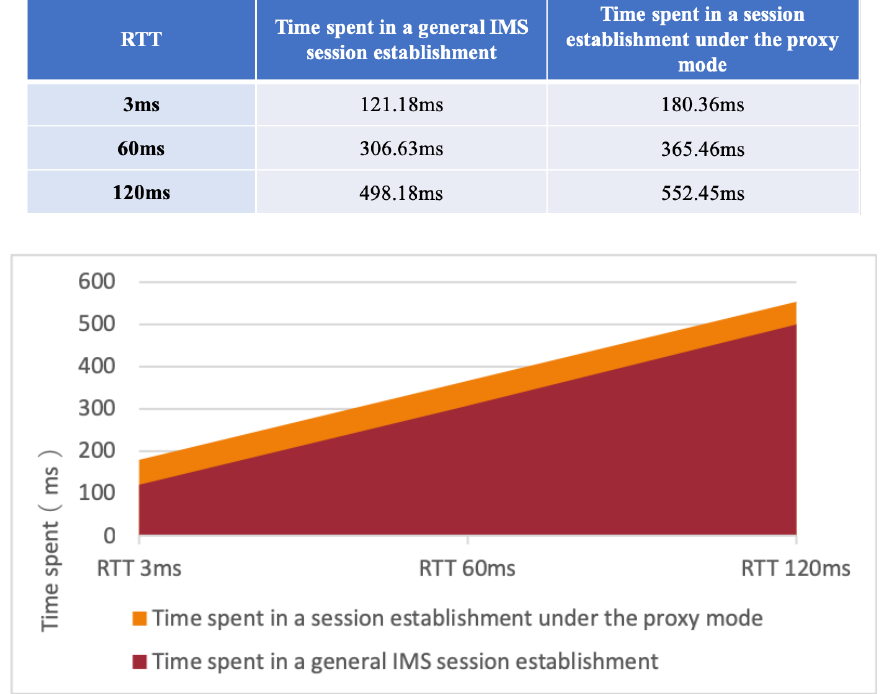
Figure 13. Comparison of time consumed in setup of a general IMS session and time consumed in setup of a session under the proxy